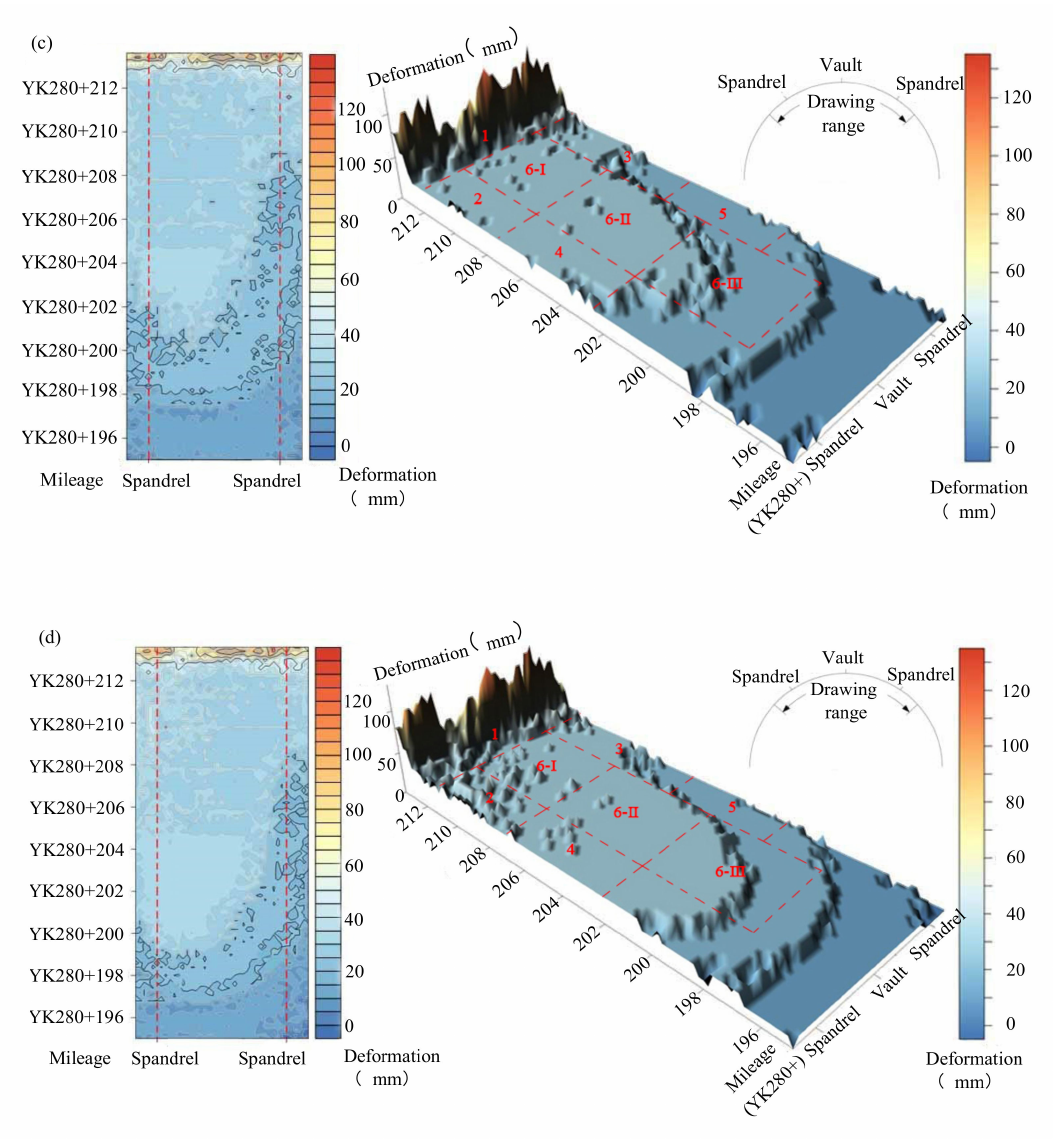
Figure 10. Isoline and 3D deformation map of tunnel deformation (Monitoring time: ( a ). 2 h; ( b ). 4 h; ( c ). 20 h; ( d ). 24